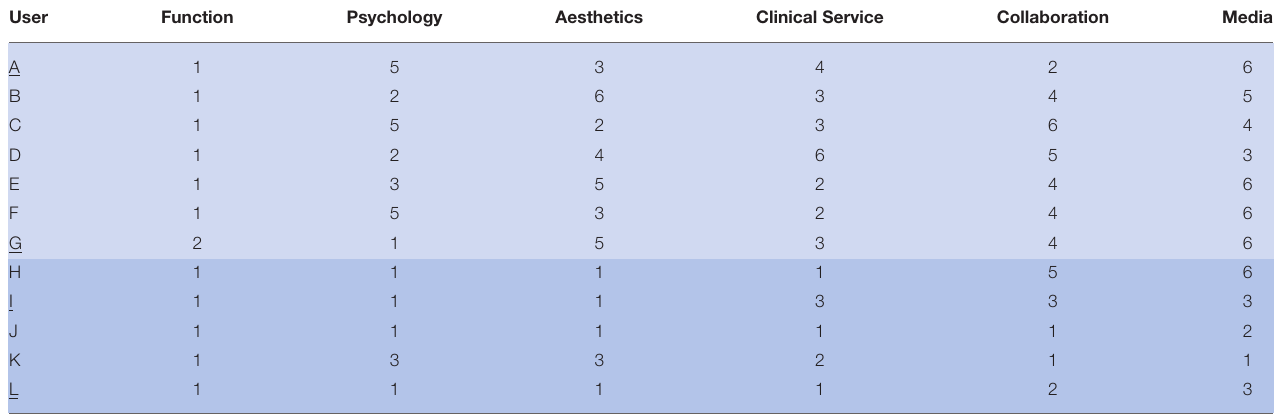
TABLE 3 | Pre-workshop survey results per